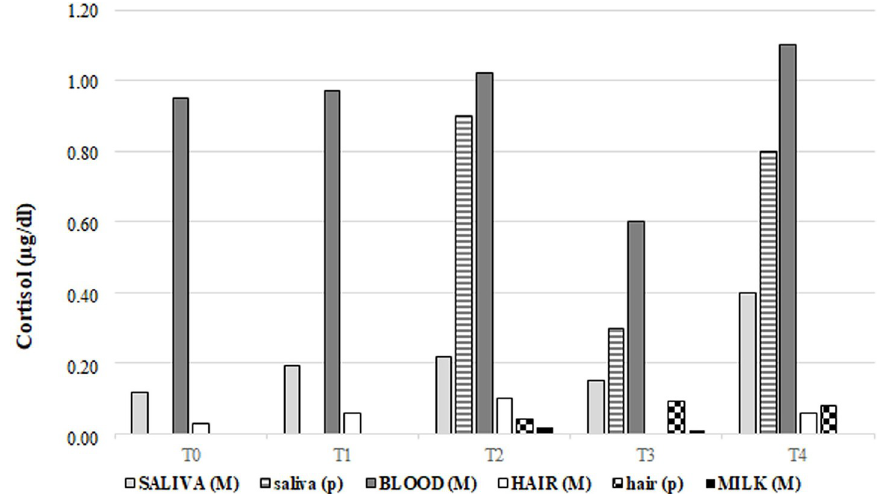
Fig 1. Maternal and neonatal cortisol concentrations in different matrices over time. T0: the fifth day of proestrus; T1: the twenty-fourth day of pregnancy; T2: the parturition day; T3: twenty-one days after parturition; T4: two months after parturition; M = maternal; p = pups.